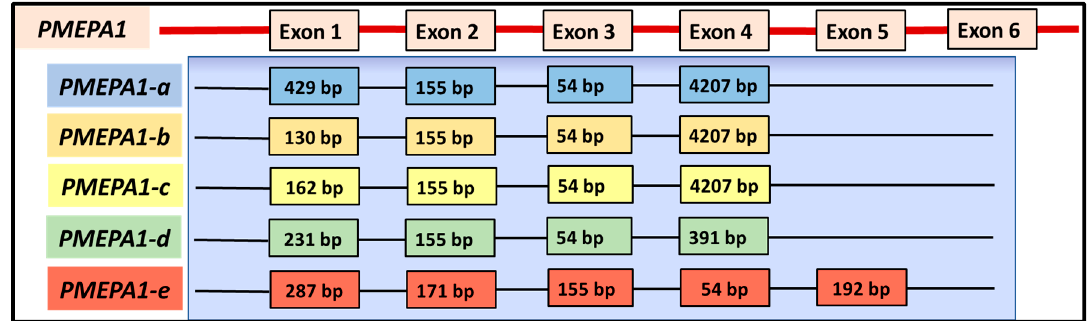
Figure 3. PMEPA1 isoforms exon-intron structure: Genome schematic representation indicating the structures of PMEPA1 isoforms and respective intron-exon corresponding to PMEPA1 gene [1].